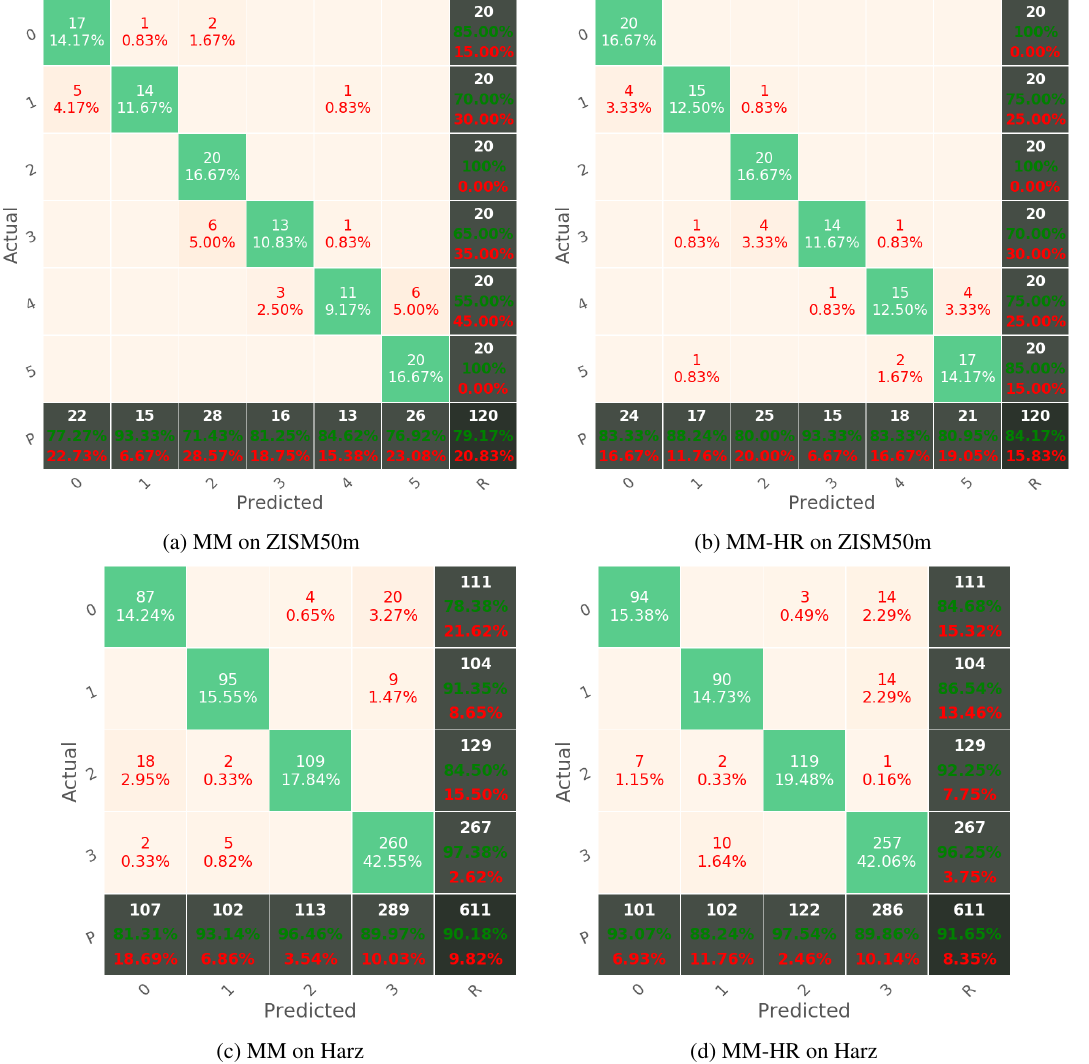
Figure 11. Confusion